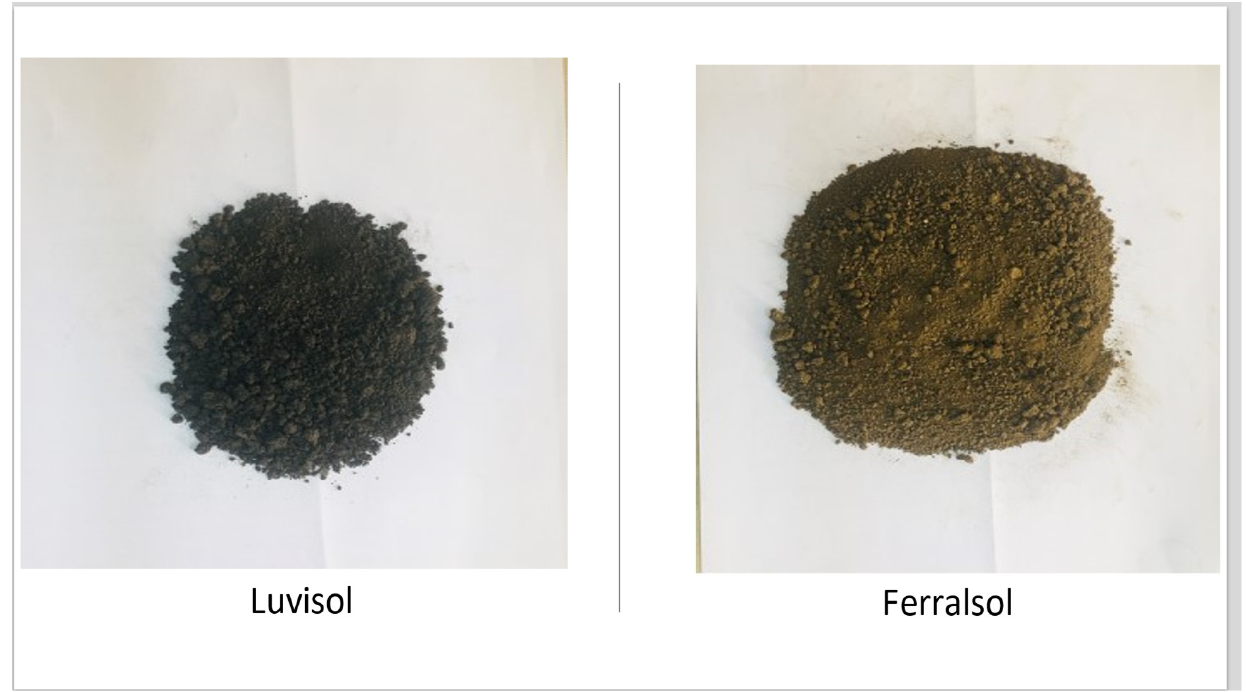
Figure 1. Comparison of the two soils used for the incubation study.